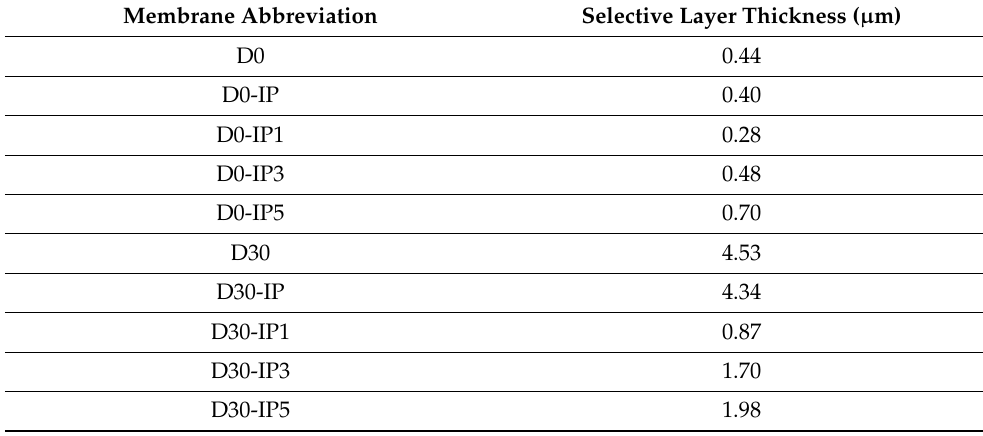
Figure 1. SEM micrographs of the cross-section of the selective layer of TFC and TFN membranes at higher and lower magnification: ( a ) D0; ( b ) D0-IP; ( c ) D0-IP1; ( d ) D0-IP3; ( e ) D0-IP5. Table 2. Thickness of the selective layer of TFN